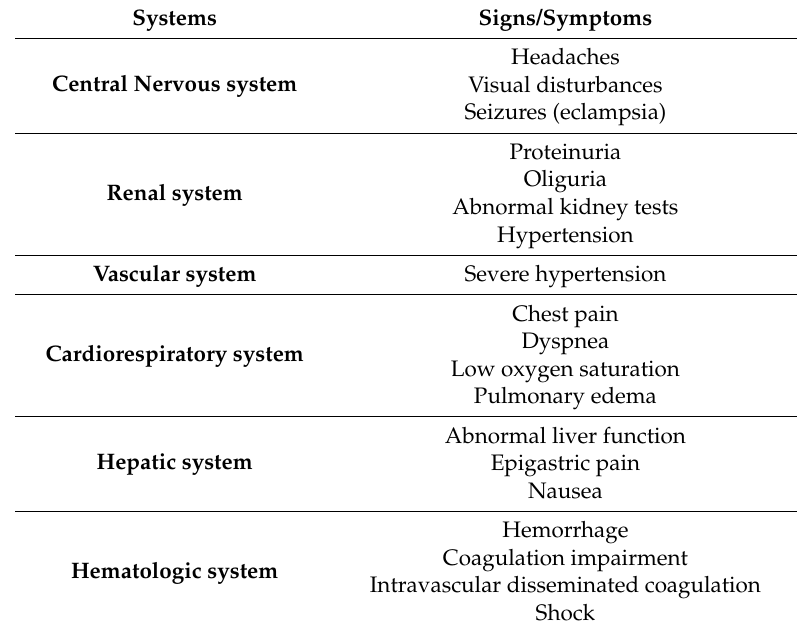
Table 1. Signs and symptoms of pre-eclampsia per organ system.